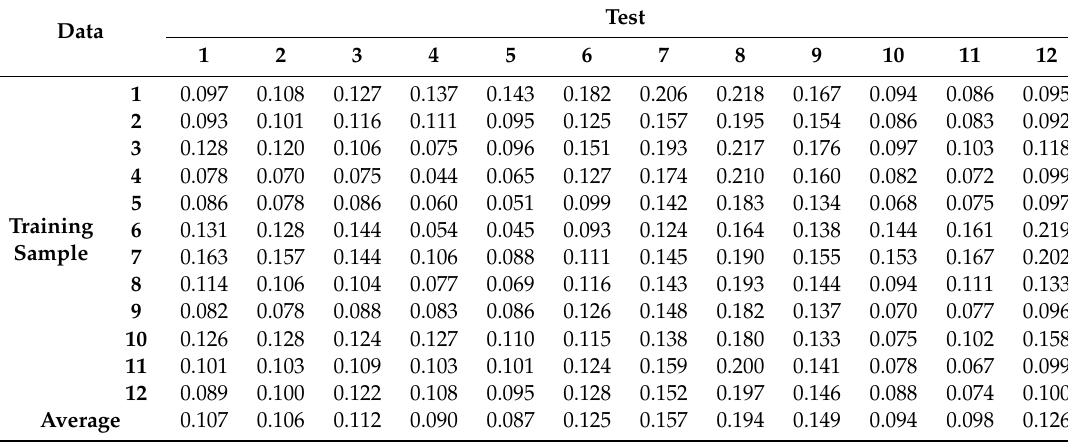
Table 3. The relative error of referred visibility under di ff erent sample conditions with sample data from 2011 to 2015.